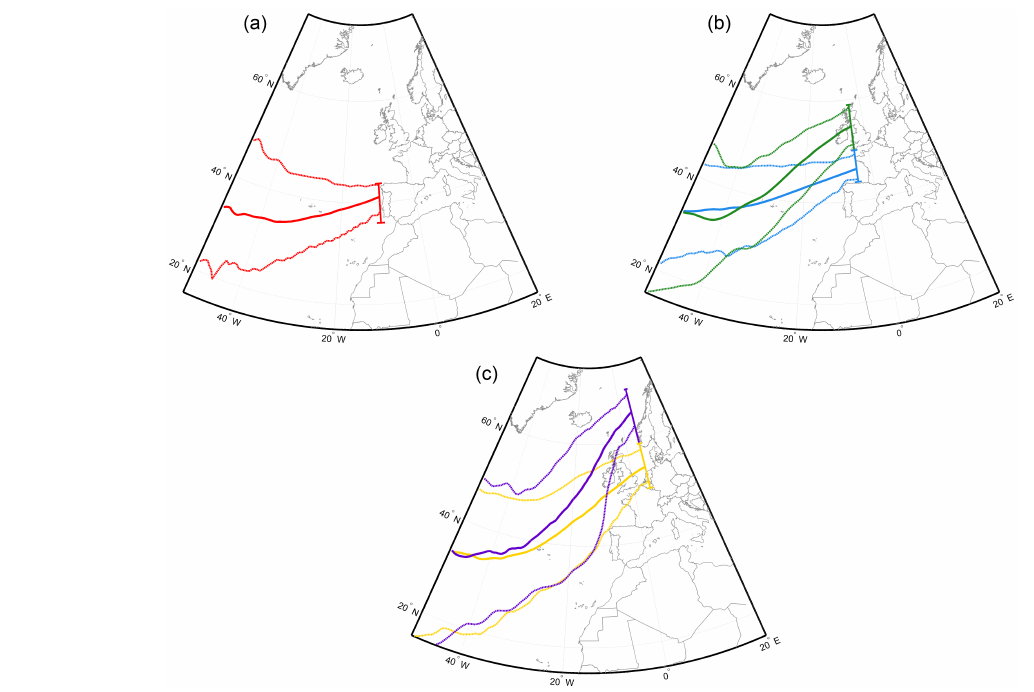
Figure 2. The median position (coloured line) and the respective 90th and 10th percentiles (dashed lines) of the atmospheric river path along the North Atlantic Ocean before arriving in each studied domain: (a) Iberian Peninsula (red), (b) France (blue) and the UK (green), and (c) southern Scandinavia and the Netherlands (yellow) and northern Scandinavia